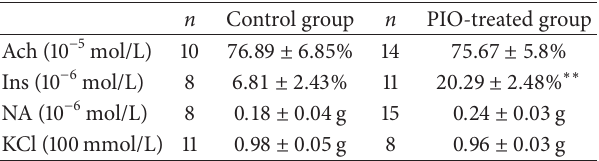
Figure 1: Effect of pioglitazone (PIO) administration on blood pressure of young SHRs. Blood pressure was measured using the plethysmography tail-cuff method on days 1, 5, 9, and 12 of the treatment period. The data represent mean ± SEM, 𝑛 = 7 . ∗ 𝑃 < 0.05 , PIO versus control. Table 2: Vasoactive responses influenced by PIO treatment on relaxation and contraction of thoracic